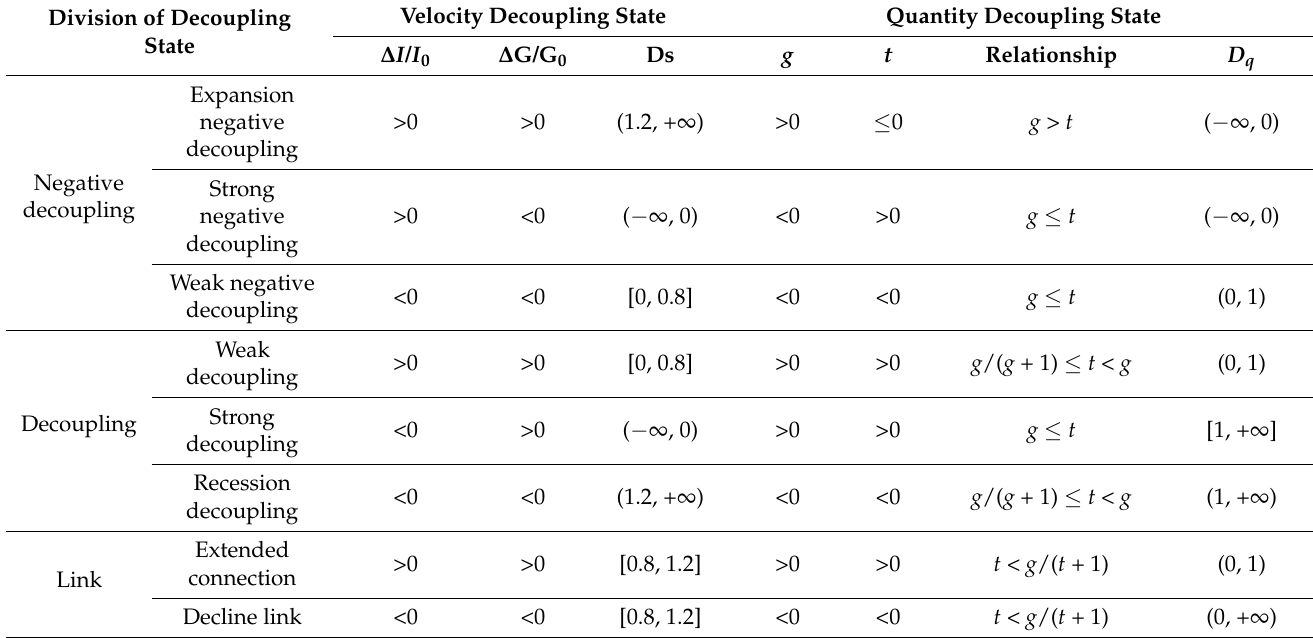
Table 2. Division of velocity decoupling and quantity decoupling